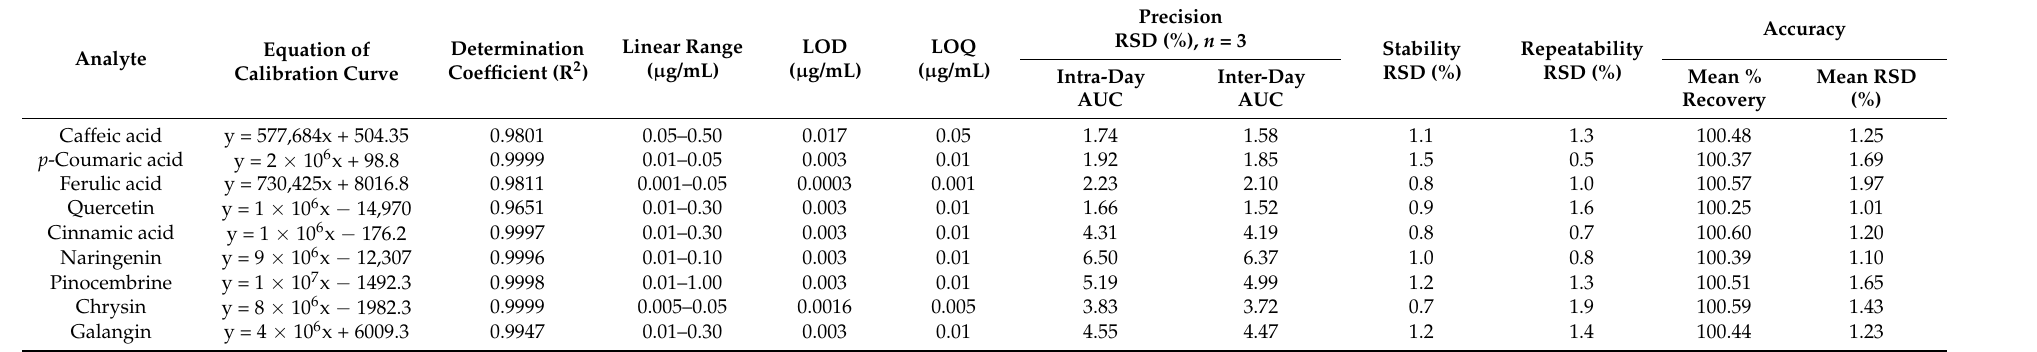
Table 2. The regression equations with R 2 value, linearity, LOD, LOQ, precision, stability, repeatability, and